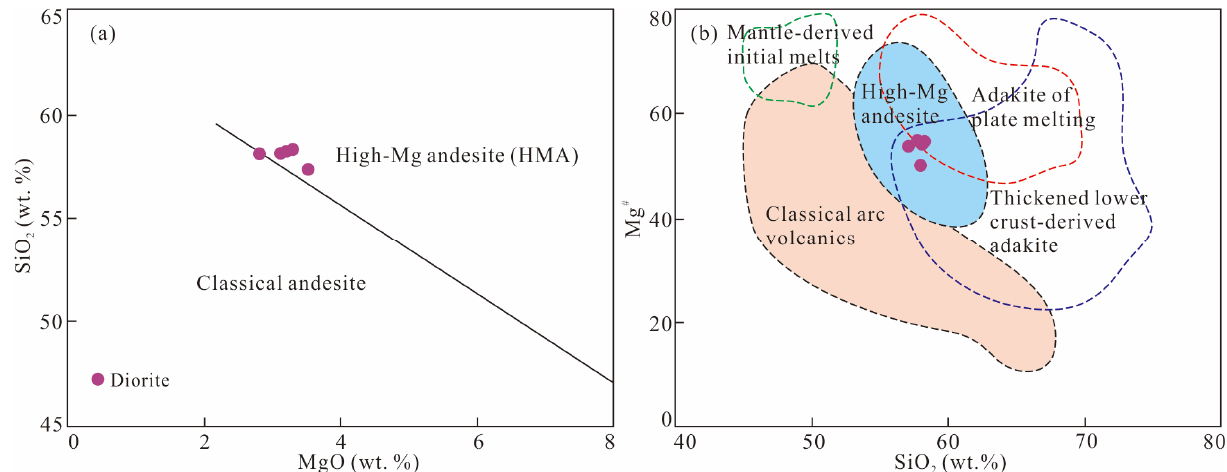
Figure 14. Diagrams of ( a ) SiO 2 versus Mg # (modified after [107]) and ( b ) Ba versus Nb/Y (modified